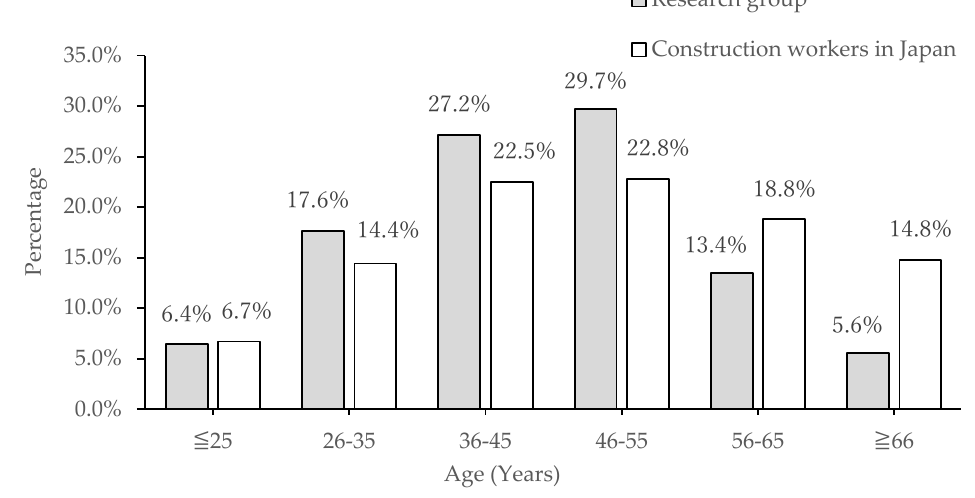
Figure 1. Comparison of construction workers by age group. Table 1. Age group frequency across the research group and the construction worker population in Japan. Age (years)